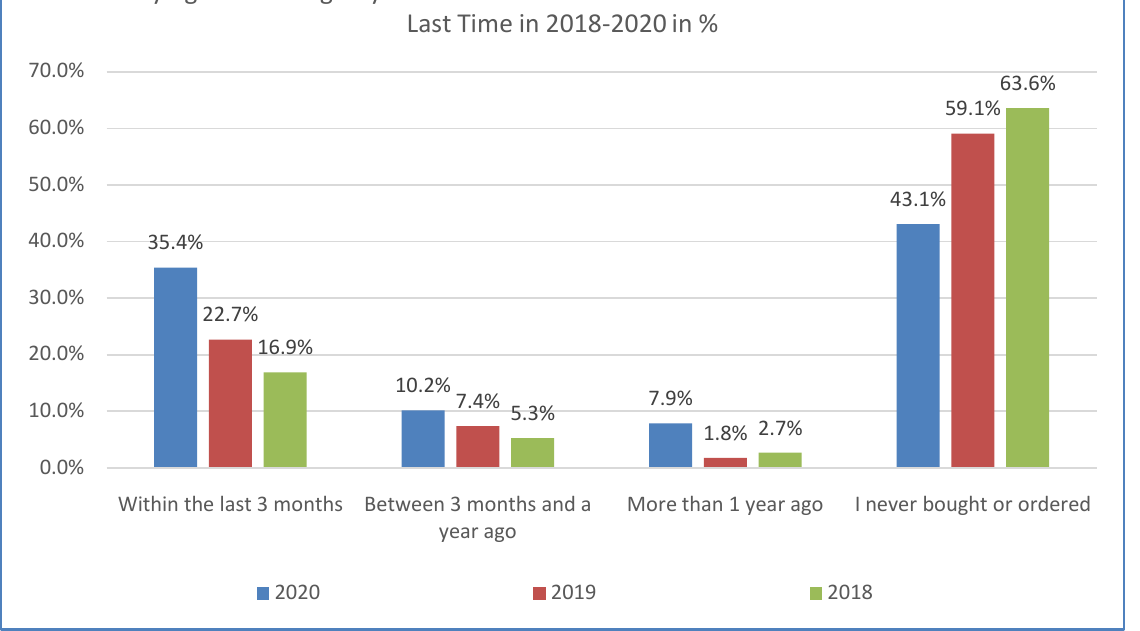
Figure 1: Buying or Ordering Any Goods and Services over the Internet the Last Time in